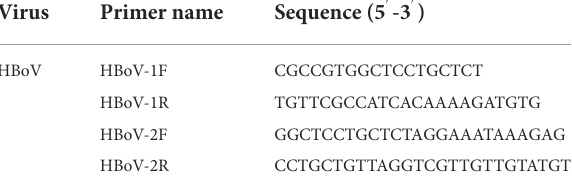
TABLE 1 Primers used in this